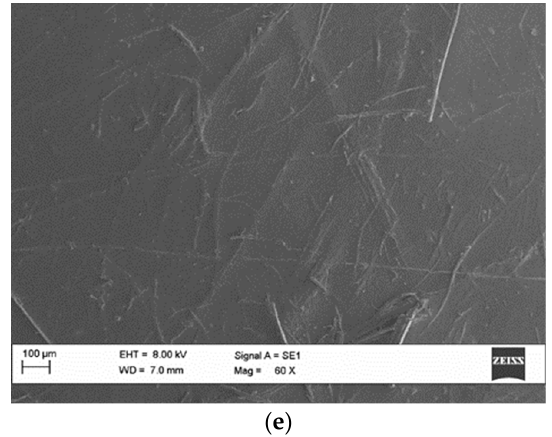
Figure 6. Scanning electron microscope (SEM) images at 60 × magnification of the surface of ( a ) sample 1, 100% rCF; ( b ) sample 2, 75% rCF and 25% flax; ( c ) sample 3, 50% rCF and 50% flax; ( d ) sample 4, 25% rCF and 75% flax; and ( e ) sample 5, 100% flax.